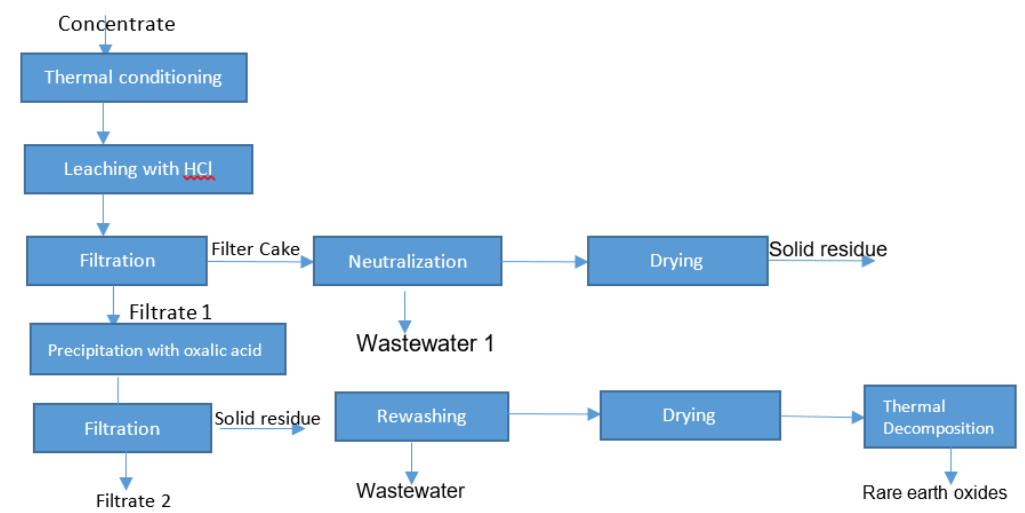
Figure 1. Research strategy for the preparation of rare earth oxide.